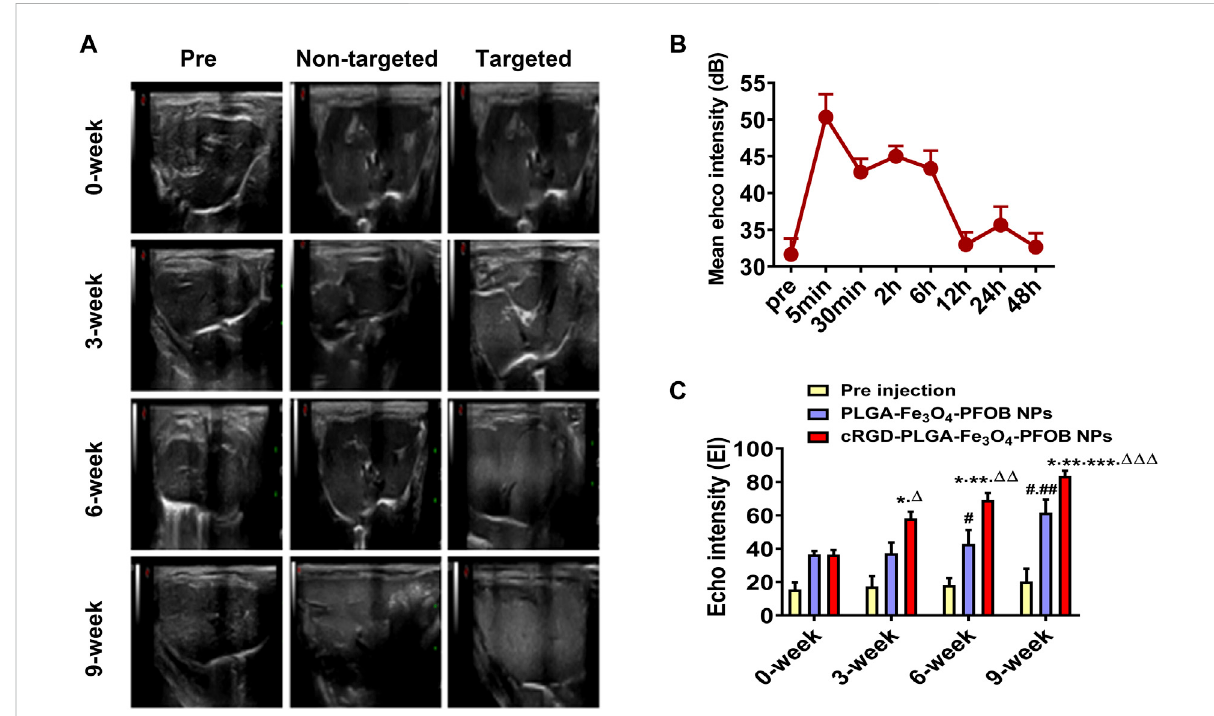
FIGURE 8 Invivo USimaging. (A) USimagesofliverbeforeandafterinjectionoftargetedcontrastagents(cRGD-PLGA-Fe contrastagents(PLGA-Fe 3 O 4 -PFOBNPs). (B) EIvalueoftheliverparenchymainthe0-weekgroupwithin48 hafterinjectionofcRGD-PLGA-Fe 3 O 4 - PFOB NPs. (C) Comparison of liver EI values before and after injection of cRGD-PLGA-Fe 3 O 4 -PFOB NPs or PLGA-Fe 3 O 4 -PFOB NPs in each group (* p < 0.05versus0-weekgroup,** p < 0.05versus3-weekgroup, *** p < 0.05versus6-weekgroup,# p < 0.05versus0-weekor3-weekgroup, ## p < 0.05 versus 6-week group, Δ P < 0.05 versus non-targeted 3-week group, ΔΔ P < 0.05 versus non-targeted 6-week group, ΔΔΔ P < 0.05 versus non-targeted 9-week